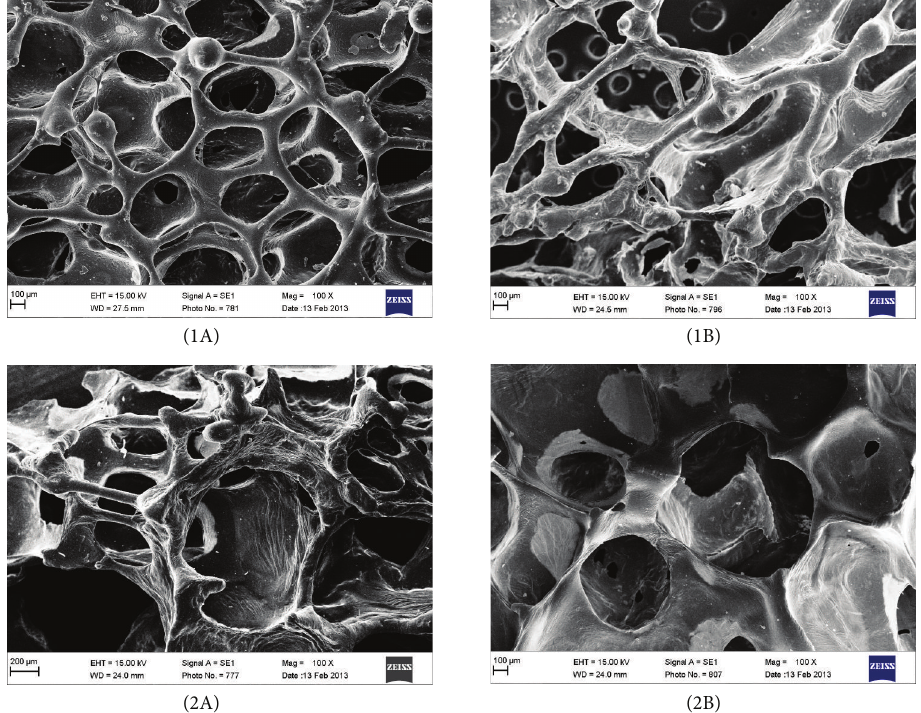
Figure 4: Normal (1A) and large (2A) pores of PUs in which chain extender was BDO and normal (1B) and large (2B) pores of PUs in which chain extender was EHEE. All images are viewed at 100x magnification.